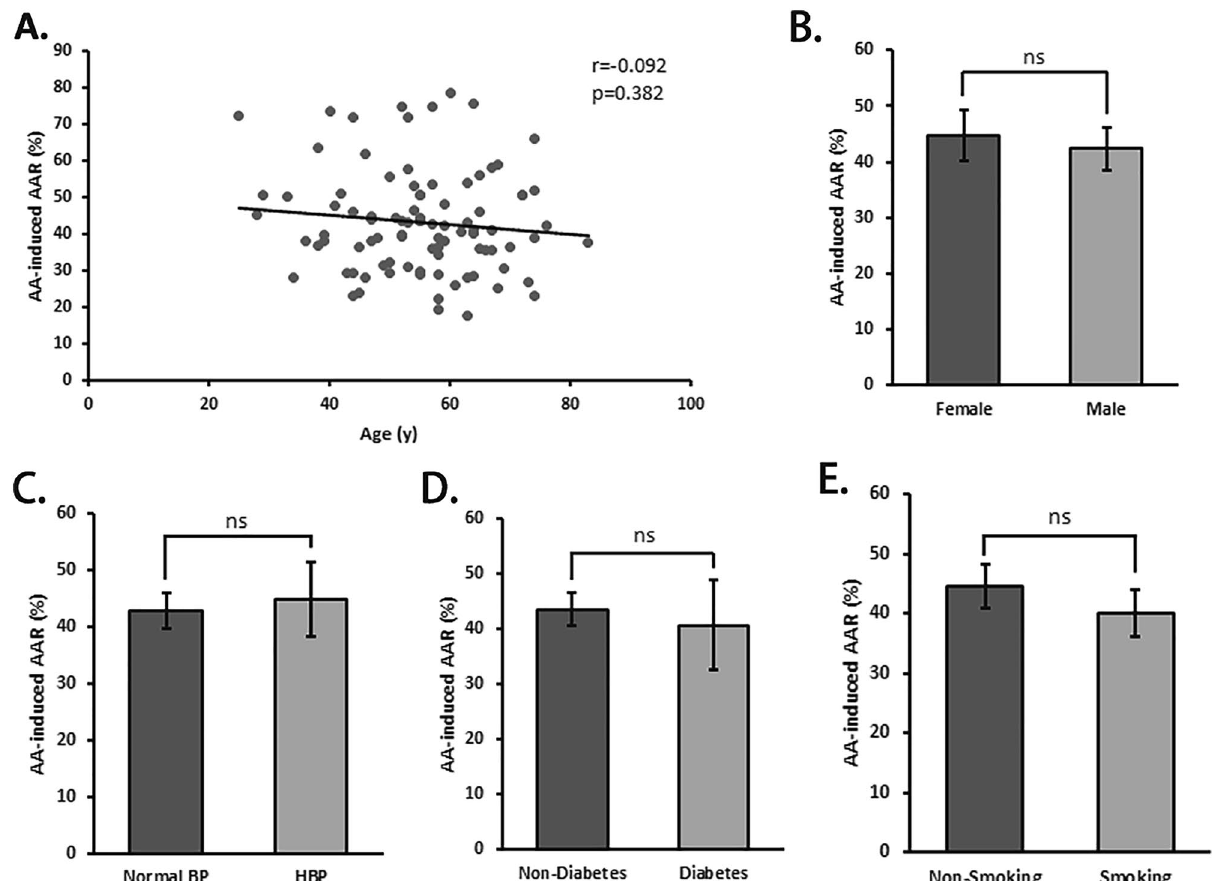
Figure 1. AA-induced platelet aggregation stratified by characteristic. AA-induced platelet average aggregation rate (AAR) in healthy subjects stratified by age ( A ), gender ( B ), hypertension ( C ), smoking ( D ), diabetes ( E